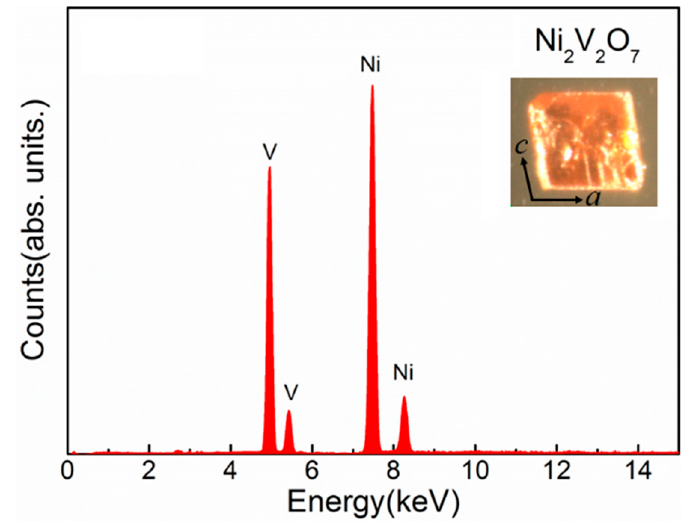
Figure A1. Energy-dispersive spectrum measured by Micro-XRF for a single crystal. The inset shows a photograph of the single crystal.